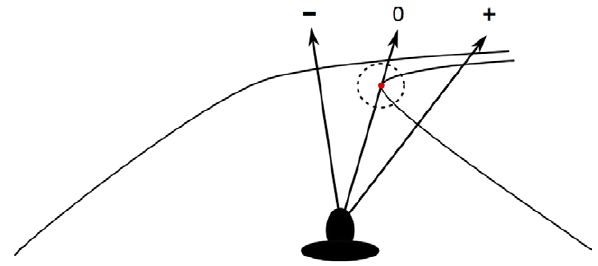
Figure 1. Schematic representation of data analysis methods. The TP (red dot), the 5 u area around the TP (dotted circle) and the sign convention for the horizontal gaze deviations from the TP (arrows) are